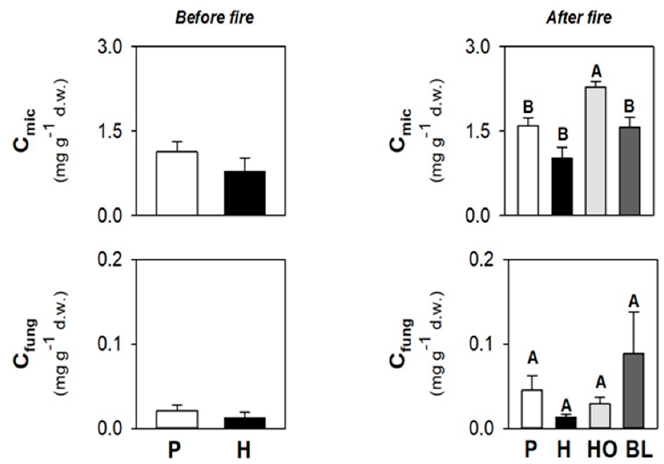
Figure 2. Mean values ( ± s.e.) of C mic and C fung of soil sampled under pine (P) and herbs (H) before the fire and under the pine (P), herbs (H), holm oak (HO), and black locust (BL) after the fire. Different uppercase letters indicate statistically significant differences ( p < 0.05) among different vegetation types in soils collected before and after the